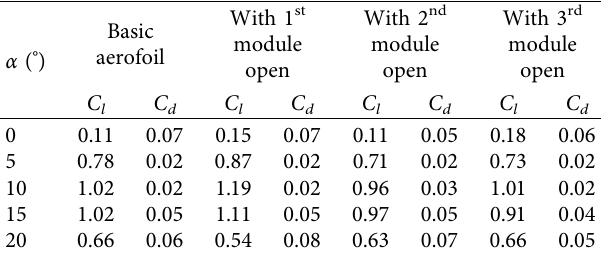
Table 4: C l and C d values of at various